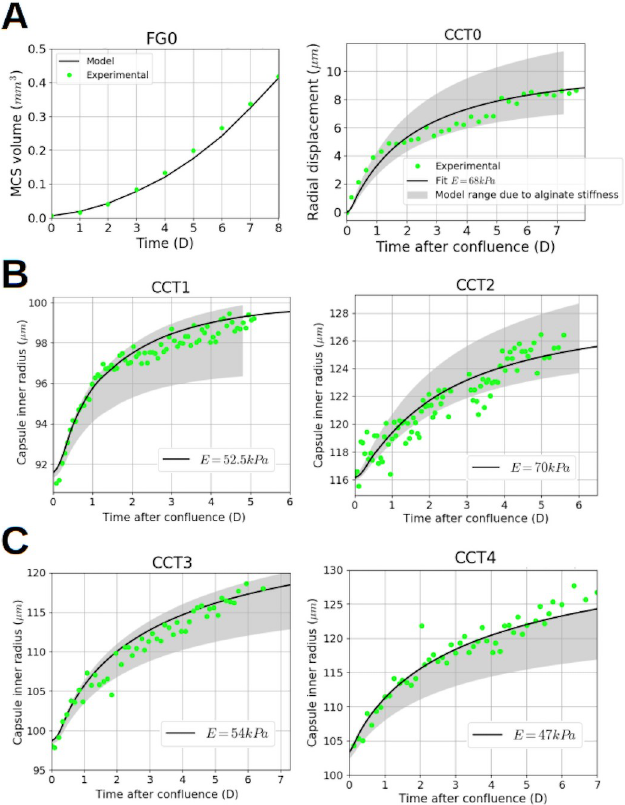
Fig 6. Sobol indices of the solution sensitivity. Sobol indices of the solution sensitivity on 7 parameters: μ dynamic viscosity, the parameter a accounting for the joint impact of the ECM thinness and cell surface tension, g t TC growth rate, g nl and g nl the oxygen consumption rate due to growth and quiescent metabolism respectively, p 1 and 0 g p crit , two thresholds which govern the pressure-induced inhibition of the TC proliferation. Free MCTS configuration (top row). A First-order analysis : Only 5 parameters remain, the governing parameter is g t rate, the sensitivity of the solution on the pressure parameters, p 1 and p crit , is 0. B Interaction : among 10 parameters tuples, one is significant ð a ; g t Þ accounting for 14.5% of the solution variance. Thus, these two parameters are not g independent and should identified together. The total variance of the solution shows that, considering all the interactions, the influence of each parameter alone is not qualitatively changed: g t to 6.1%, a from 6.2% to 5.1%. Encapsulated MCTS configuration (bottom row). C First-order analysis : the governing parameter is p crit the inhibitory pressure of tumor cells growth (73.5% of the solution variance). D Interaction : the sum of 21 parameters tuples represents 3.6% of the solution variance (the detail of 21 tuples can be found in Appendix B. Sensitivity analysis, S5